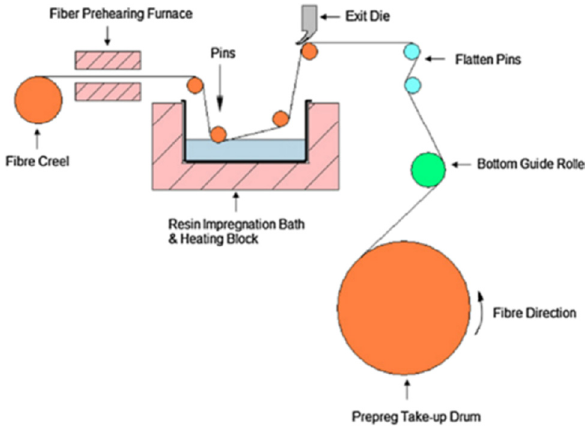
Figure 8: Schematic diagram of CNT - CFRP prepreg manufacturing. CNTs are dispersed in resins and combined with fi bers [ 38 ]